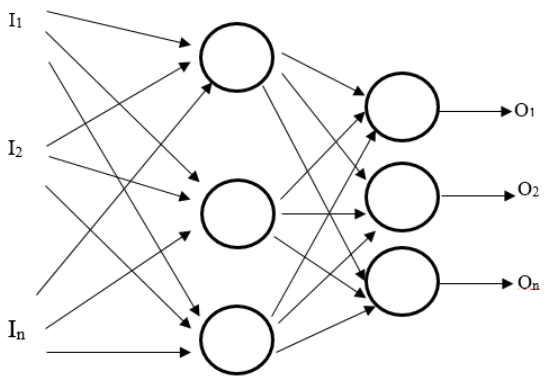
Figure 3. Multilayer perceptron.